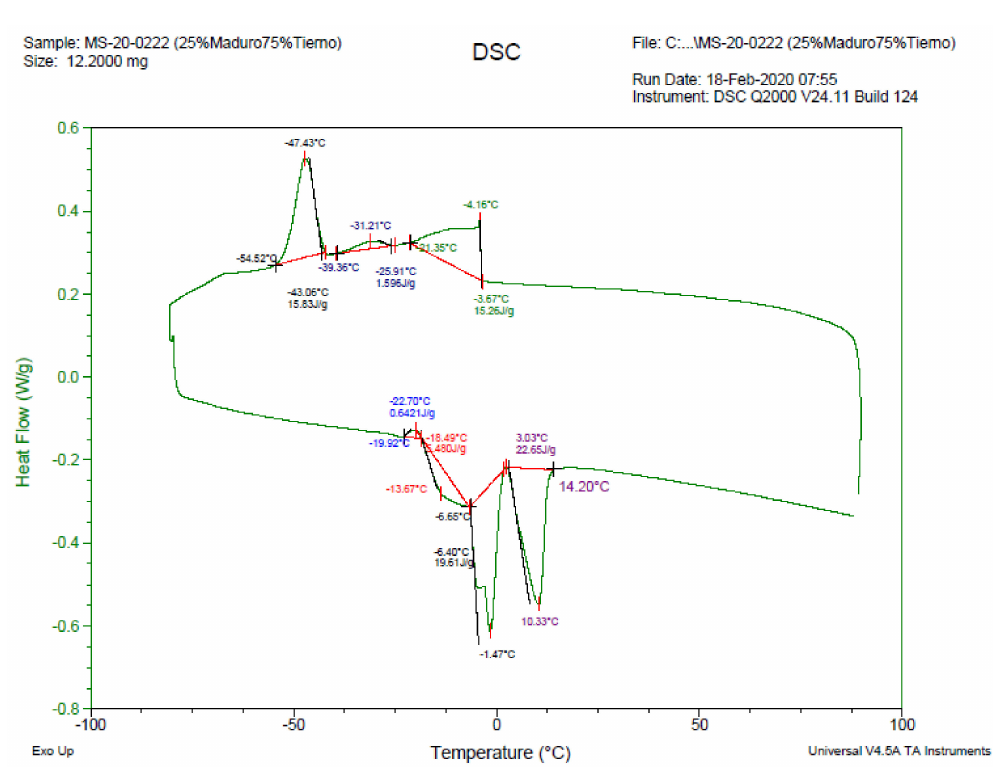
Figure A7. DSC Sample